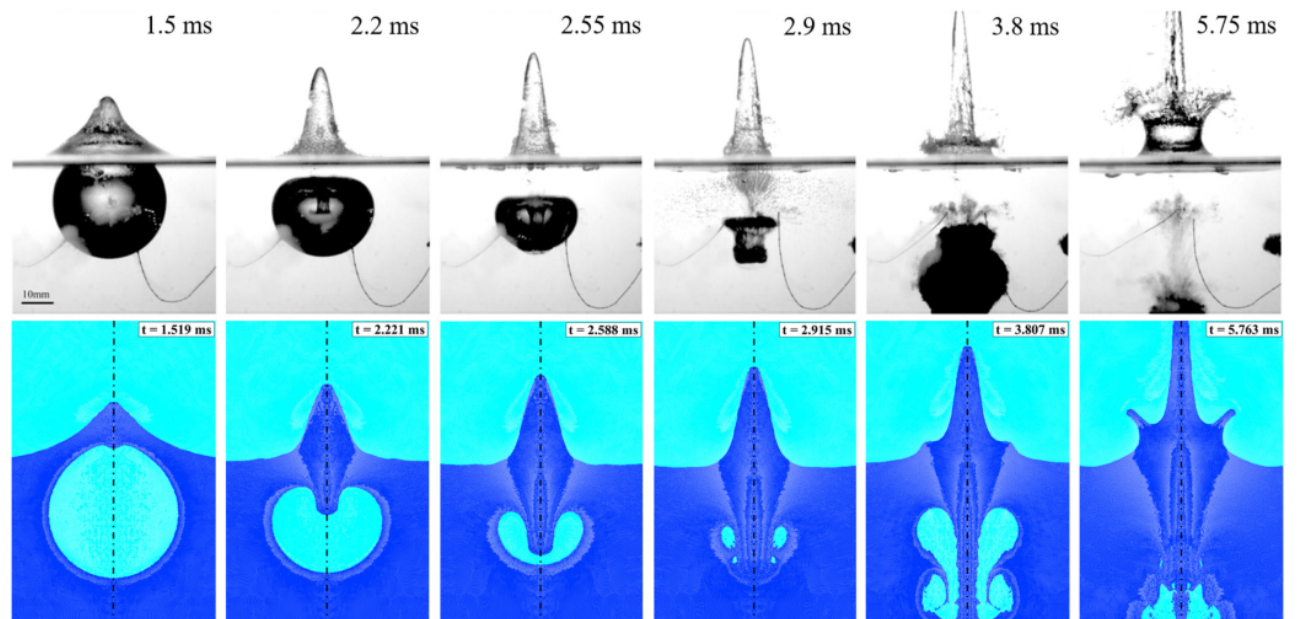
Figure 15. Comparion between SPH simulations [70] and experimental snapshots [12] for a sparking bubble below the free